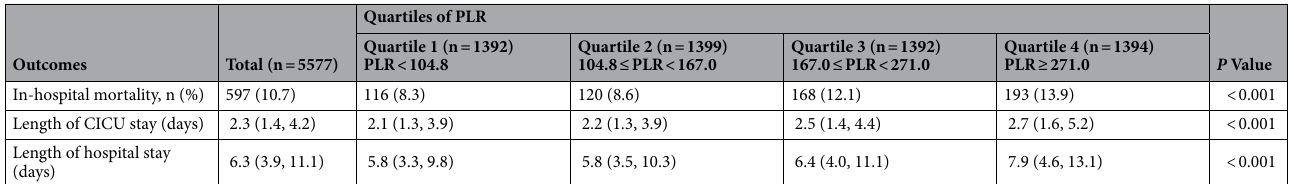
Table 2. Outcomes of patients stratified by PLR quartiles. Continuous variables were presented as median (IQR). Categorical variables were presented as number (percentage). P values were calculated using Kruskal– Wallis test or Chi-square test to compare differences in outcomes between different PLR quartiles. PLR platelet- lymphocyte ratio, CICU cardiac intensive care unit.